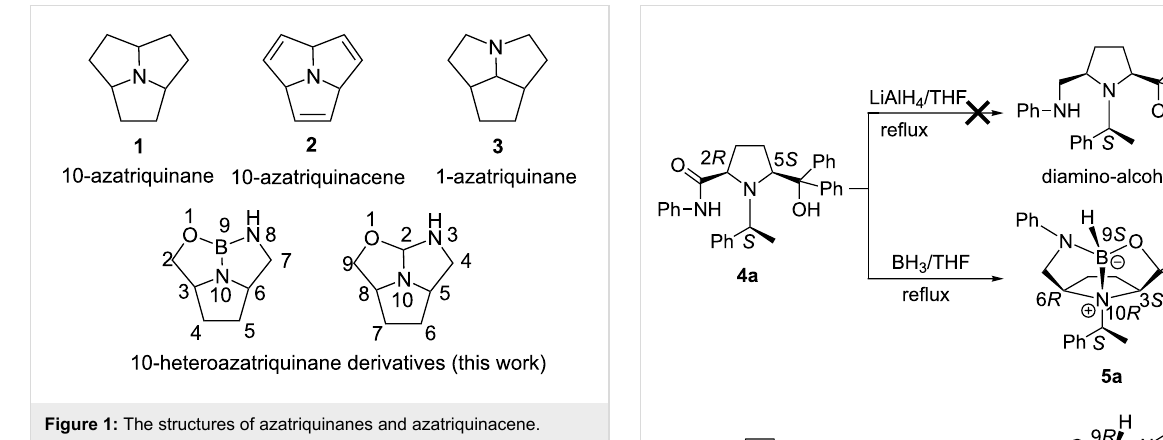
obtain several novel bifunctional N -hetereocyclic carbenes (NHCs) [10-14] from compounds 4 through three steps, including reduction, debenzylation and cyclization (Scheme 1), but this failed. However, we have found a novel one-pot tandem cyclization of these enantiopure asymmetric cis -2,5-disubsti- tuted pyrrolidines to produce chiral trisubstituted 10-heteroaza- triquinane derivatives. To the best of our knowledge, there is very little research on the synthesis of 10-heteroazatriquinanes, and the chiral 10-heteroazatriquinanes are unknown up to